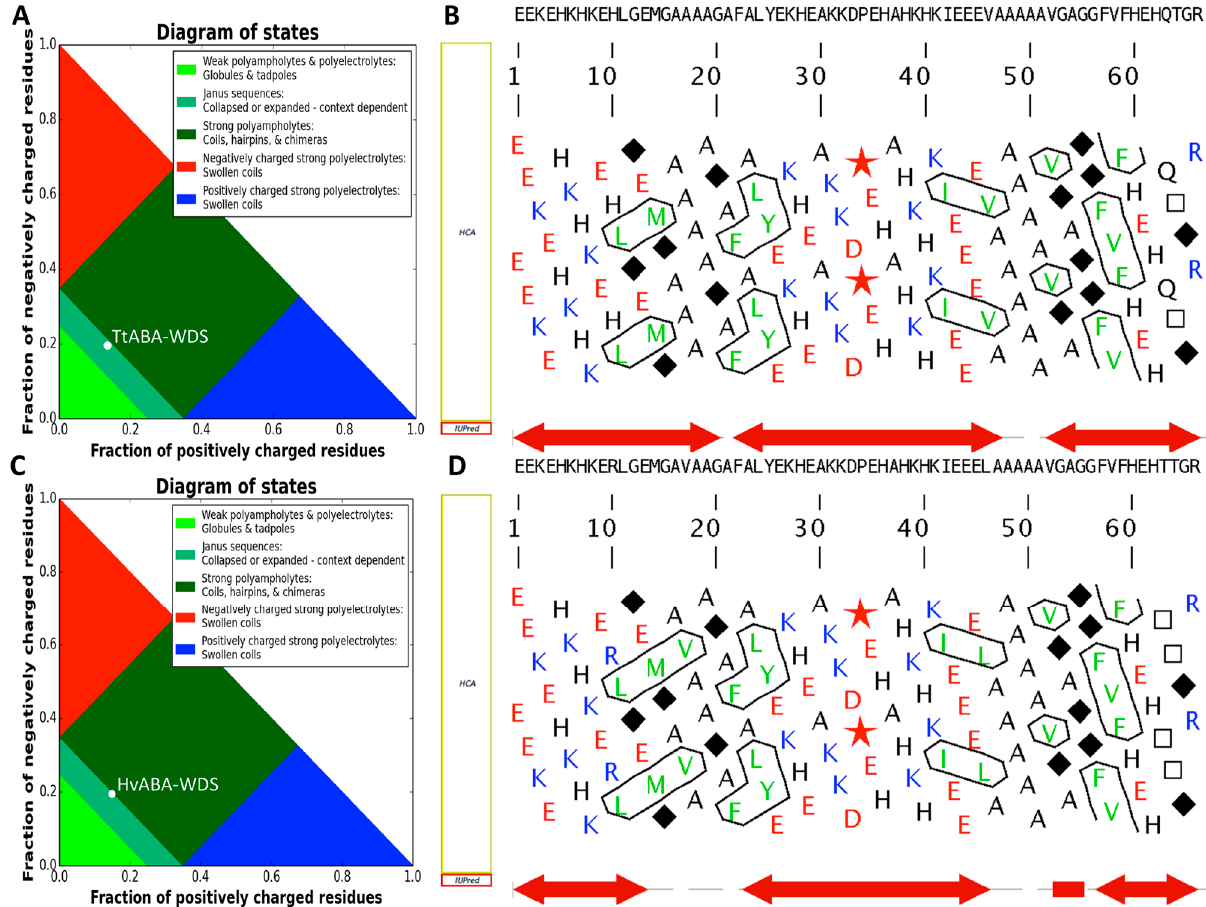
Figure 2. Phase diagram plots of TtABA-WDS ( A ) and HvABA-WDS ( C ) domains as provided by CIDER (http://pappulab.wustl.edu/CIDER/). MeDor [34] ouputs of TtABA-WDS ( B ) and HvABA-WDS ( D ) featuring the amino acid sequence above the HCA plot. The regions predicted as disordered by IUPRED [35] are represented by bi-directional red arrows.